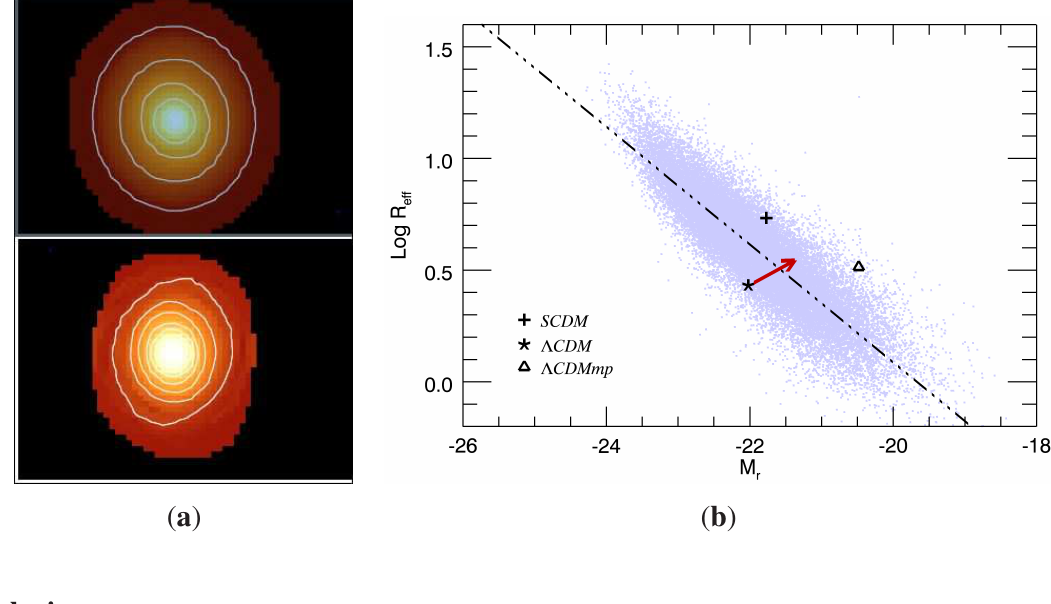
Figure 19. ( a ) The 2D-distribution of the optical r -band magnitude in the XY-plane. Superposed are elliptical isophotes (white solid lines). The top panel is for SCDM , the middle panel for Λ -CDM, and the bottom panel for Λ -CDM ; ( b ) Magnitude-Effective mp Radius relation in the r -band for the ETGs selected from the SDSS DR2 database following the criteria from [275]. Results for the three model galaxies are shown for comparison. Reproduced with permission from [237]. Copyright 2010 Astronomy and